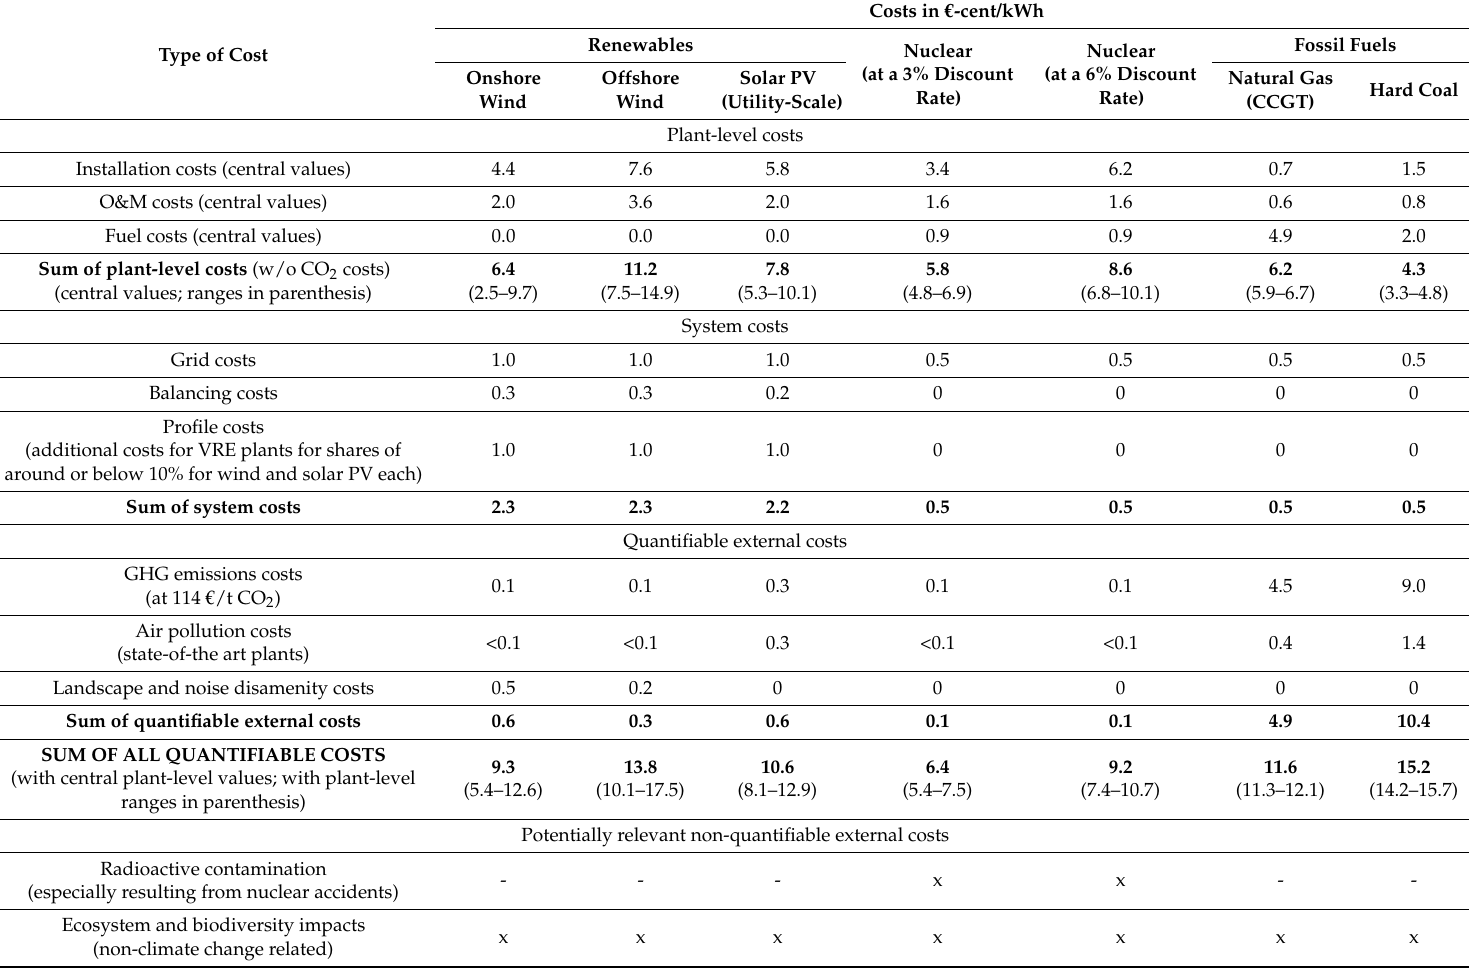
Table 10. Overview of the estimated specific social costs of electricity generation in Europe from several types of current newly-built power